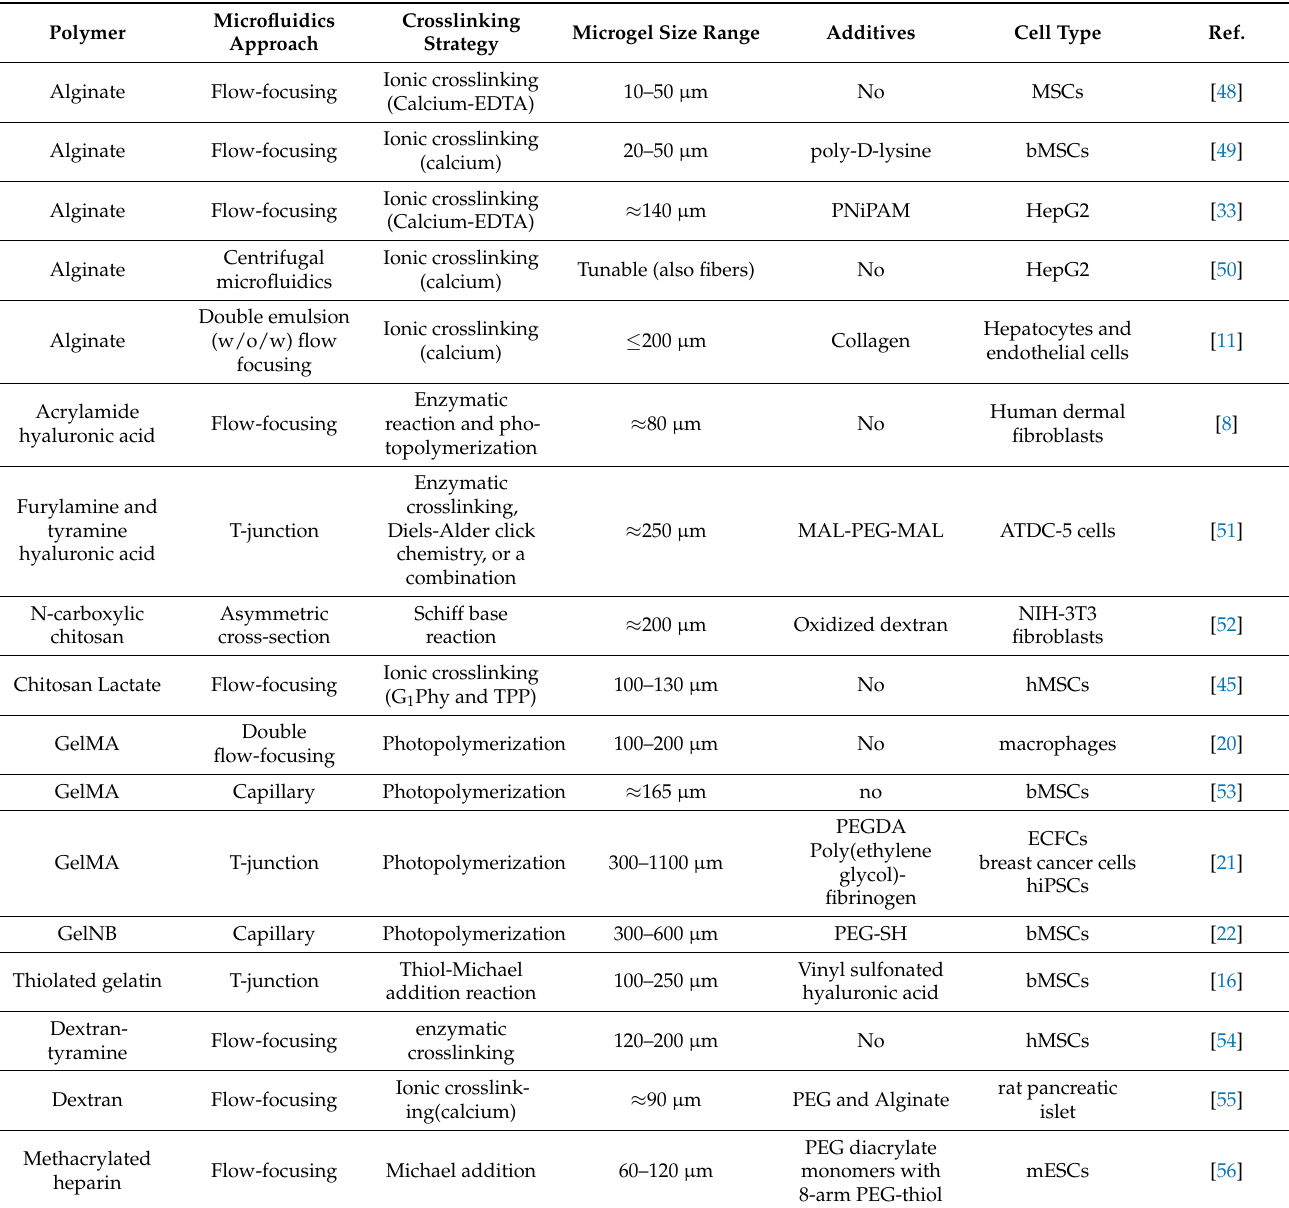
Table 1. Summary of the studies exposed in this review regarding microfluidics generation of cell-laden microgels.